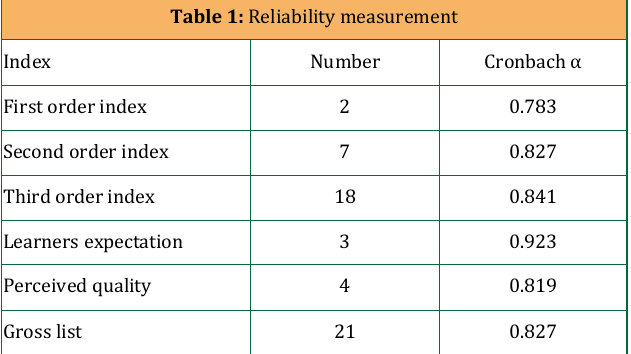
Table 1: Reliability measurement